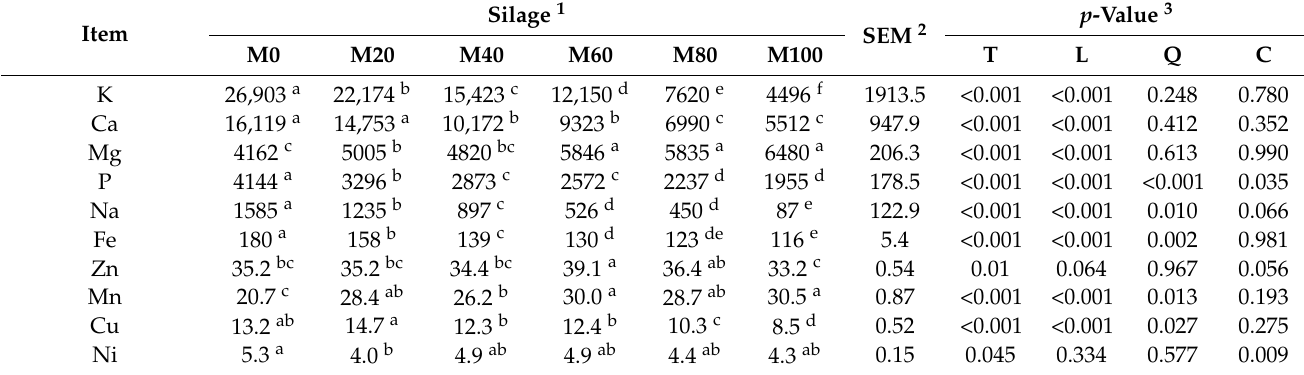
Table 2. Mineral profile (mg/kg DM) of silage prepared with lucerne, sweet corn maize, and their mixtures ( n = 3).